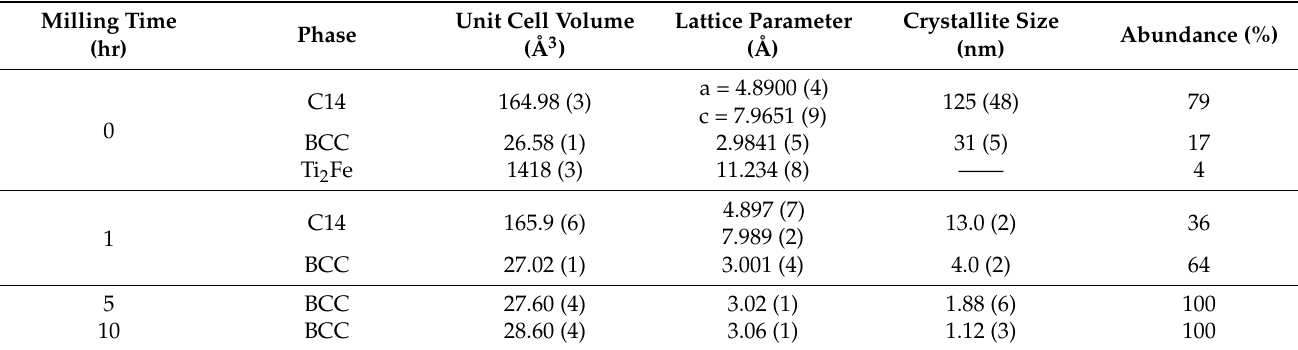
Table 7. Crystal parameters and abundance of each phase in as-cast Ti 0.3 V 0.3 Mn 0.2 Fe 0.1 Ni 0.1 alloy before and after milling. Error on the last significant digit is indicated in parentheses.